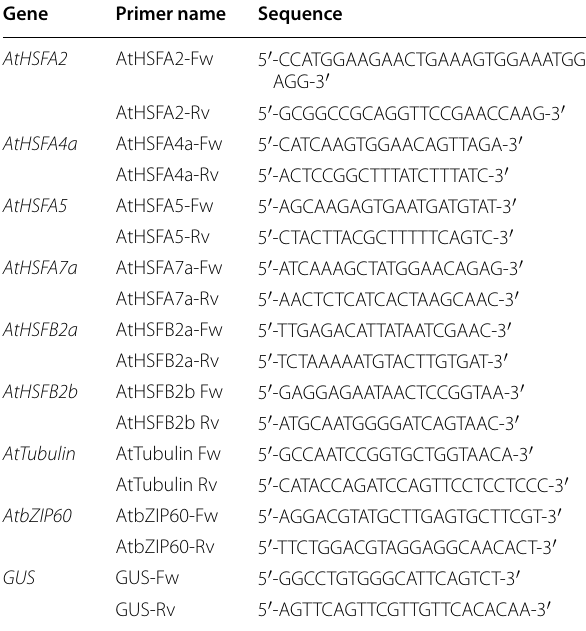
Table 1 Oligonucleotides used in